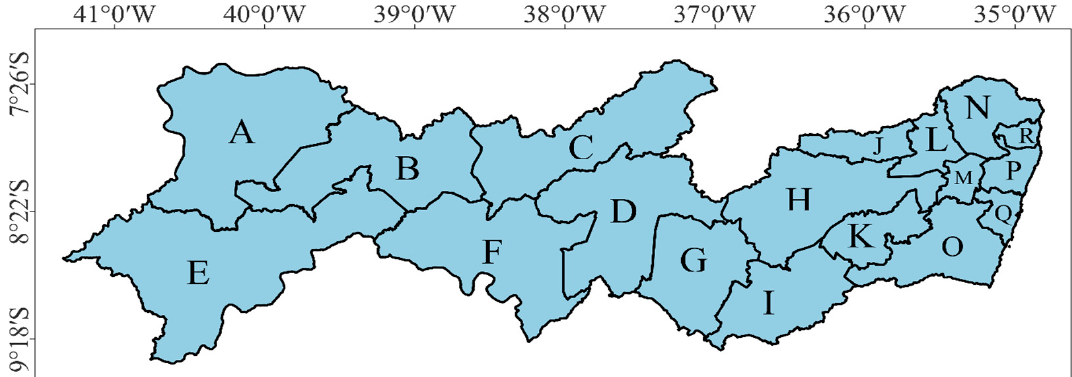
Figure 5. Map of Pernambuco state divided into its microregions. A—Araripina; B—Salgueiro; C—Pajeú; D—Moxotó; E—Petrolina; F—Itaparica; G—Vale do Ipanema; H—Vale do Ipojuca; I— Mata Setentrional; O—Mata Meridional; P—Recife; Q—Suape; R—Itamaracá.